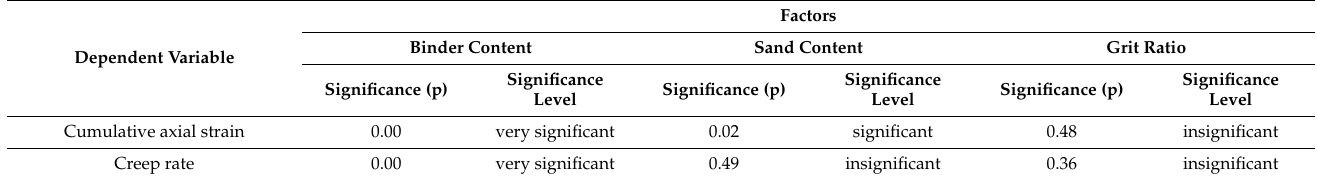
Table 4. Variance analysis